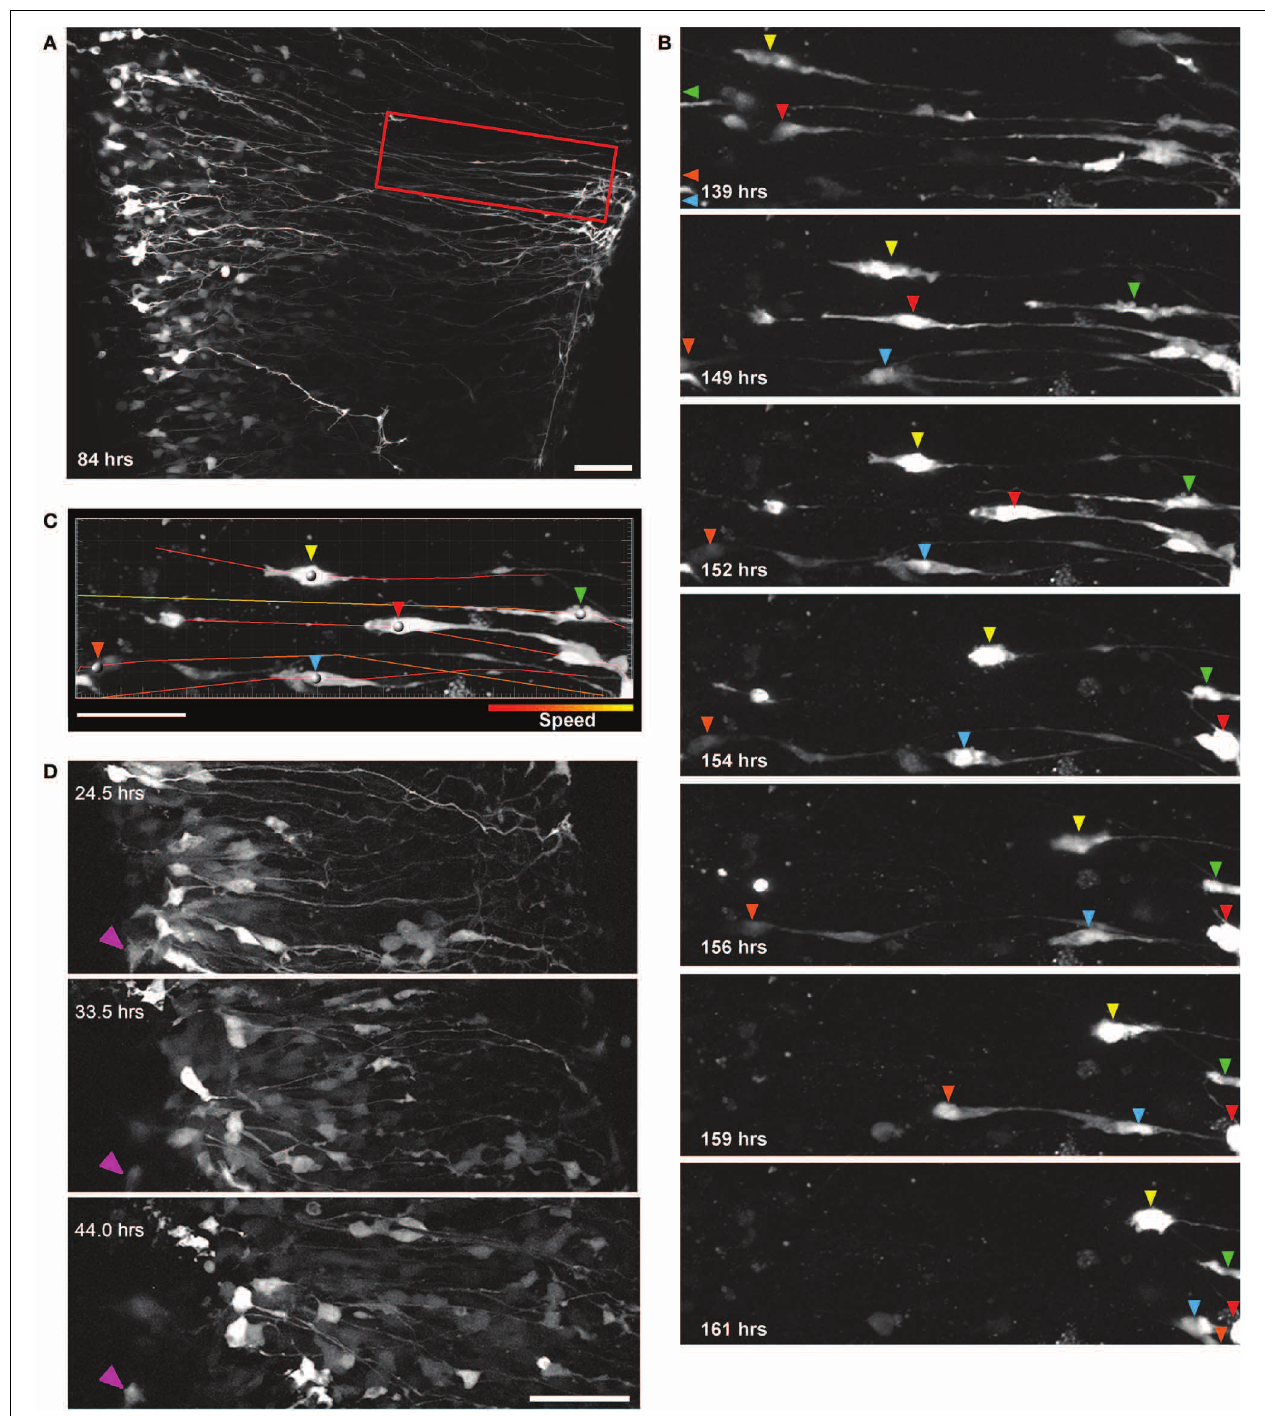
FIGURE 3 | Direct observation of radial glial cell migration using two-photon extended time-lapse imaging. (A) GFP expression in a population of radial glial cells 84h after transfection with BLBP-GFP plasmid at E14; cell somata are aligned in the ventricular zone with radial processes extending out toward the pial surface. Region outlined in red is shown in (B) where individual GFP labeled cells (differentiated by colored arrows) can be seen migrating out to the pial surface using somal translocation over a time period of 22h beginning 139h after transfection. (C) Parameters such as migration speed can be analyzed